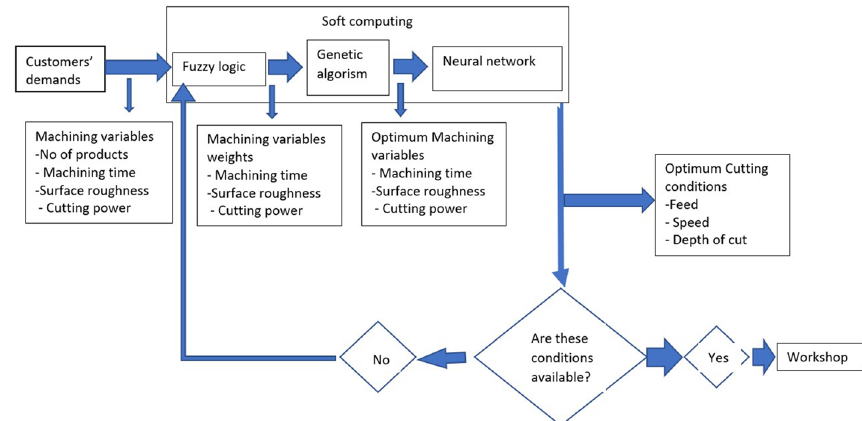
Fig. 1 Flow chart for the porposed